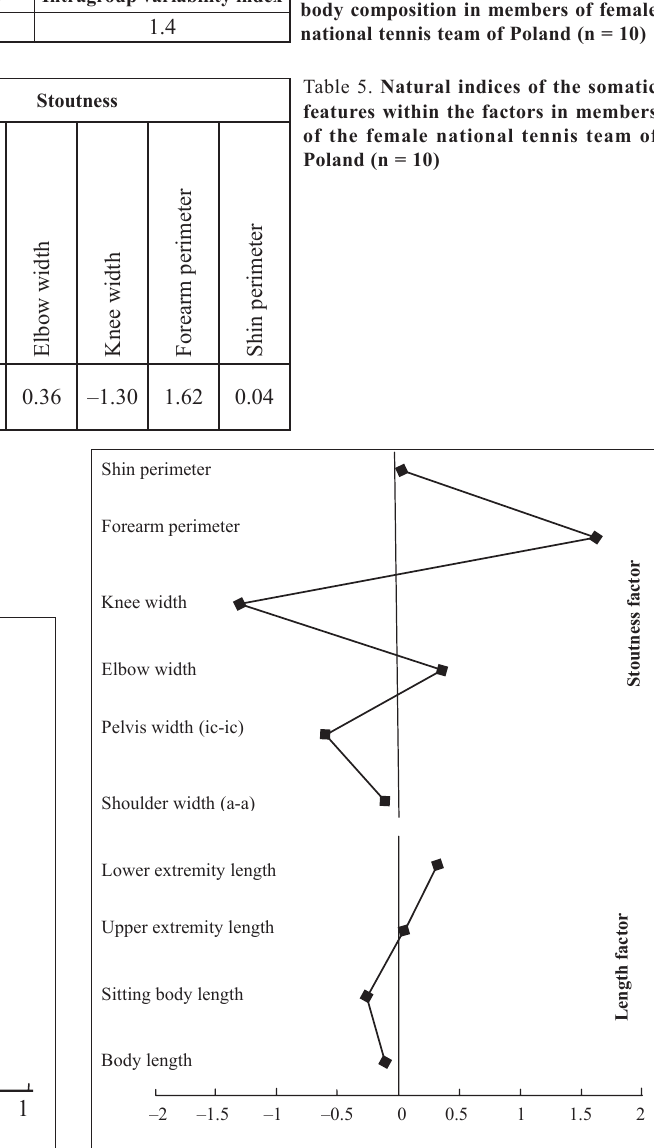
Table 4. Natural indices of factors of the body composition in members of female